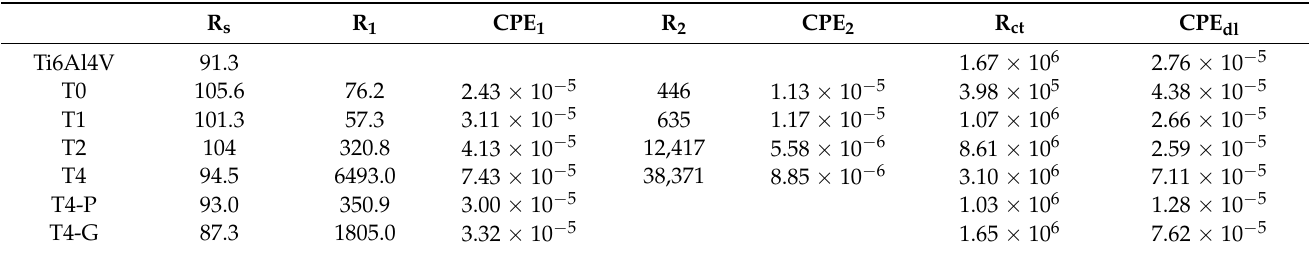
Table 4. Fitted circuit values for untreated, mechanically ground and polished, and nitriding